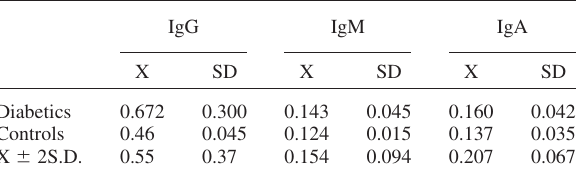
TABLE III Study of the levels of circulating immune complexes (CIC IgG, CIC IgM, CIC IgA) in diabetics and control sera using CIF-ELISA IgG IgM IgA X SD X SD X